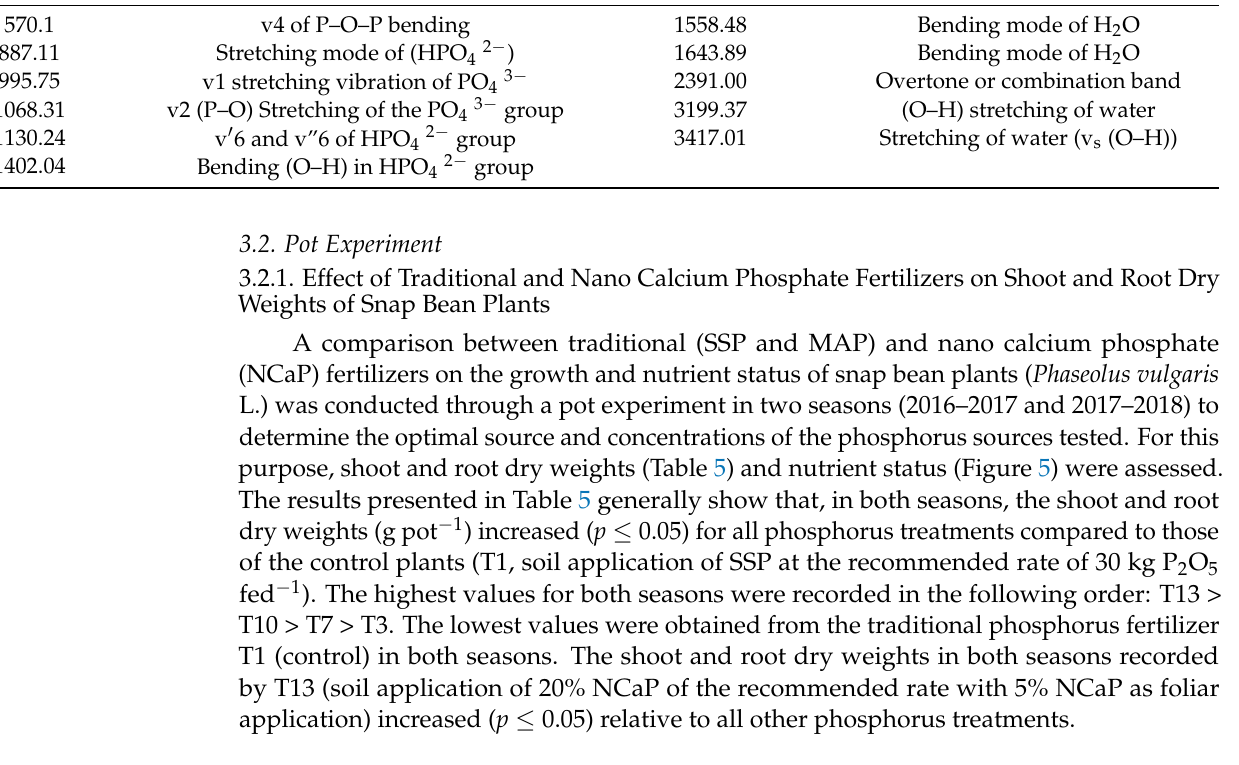
Table 5. Effect of different phosphorus treatments on shoot and root dry weights (g pot − 1 ) of snap bean plants at 45 days after sowing during the two seasons, SI (2016–2017) and SII (2017–2018)